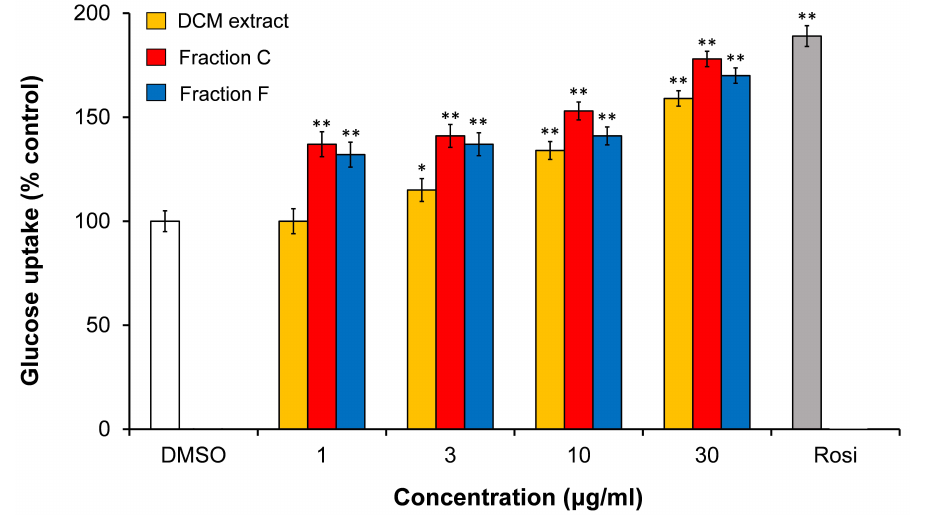
Figure 4. Effect of a DCM extract of carrot roots and active fractions (C and F) on insulin-dependent GU in mature 3T3-L1 adipocytes at 10 nM insulin, relative to 0.1 % DMSO (vehicle, 100%) and the positive control Rosi (1 µ M). All values are expressed as a mean ± SD of three independent experiments in triplicates. * p < 0.01, ** p < 0.001, indicate significance relative to the vehicle.